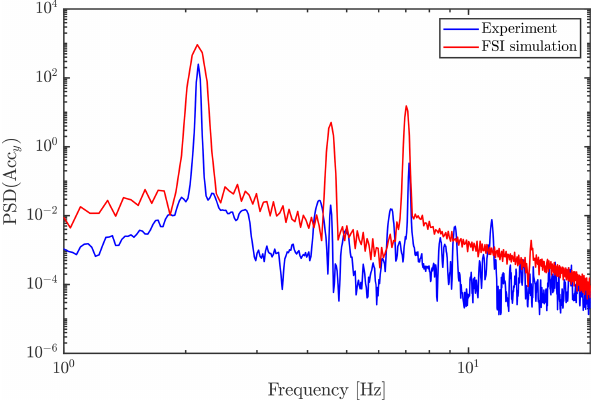
Figure 8. Acceleration measured in the experiment and simulated using FSI-CFD at 12.8m.